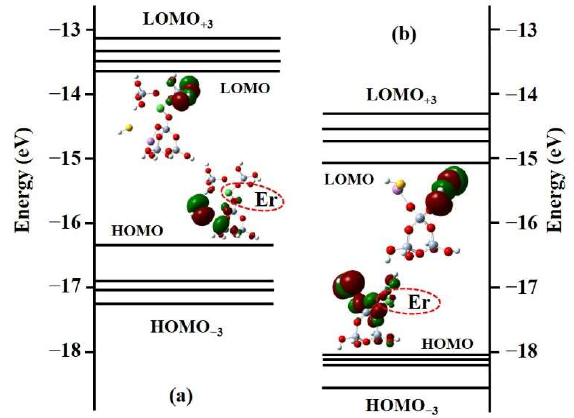
Figure 4. Energy eigenvalues and electron density distributions of the HOMO and LUMO; ( a ) Er-3MR structural model; ( b ) spin-up state of PbS/Er-3MR structural model.